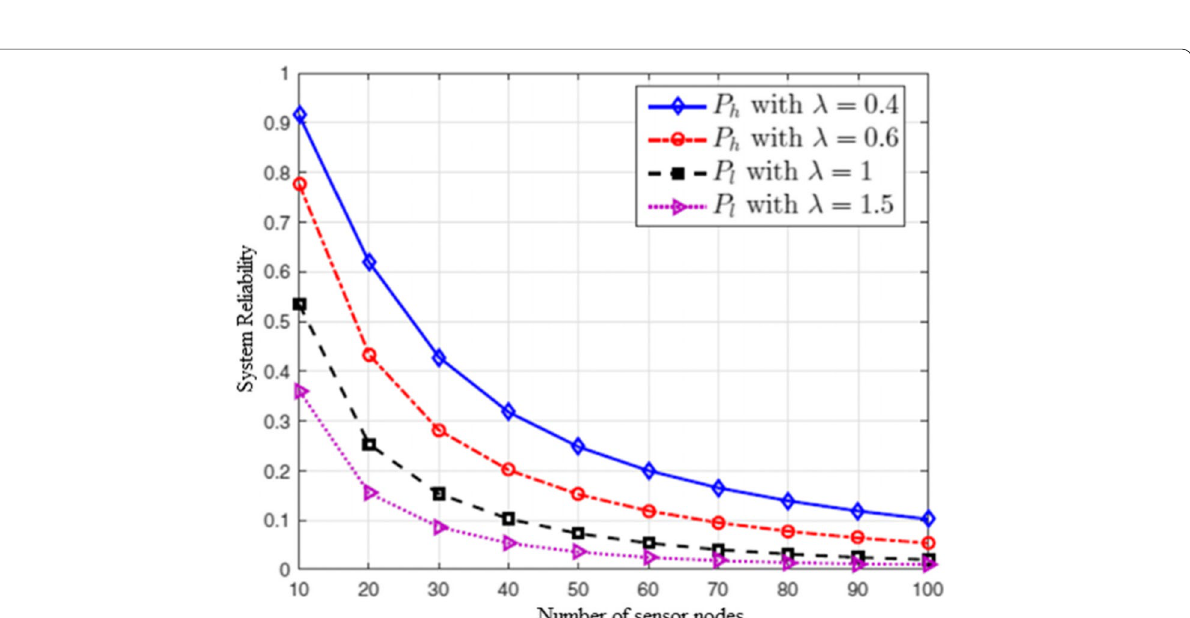
Fig. 7 Performance evaluation in terms of